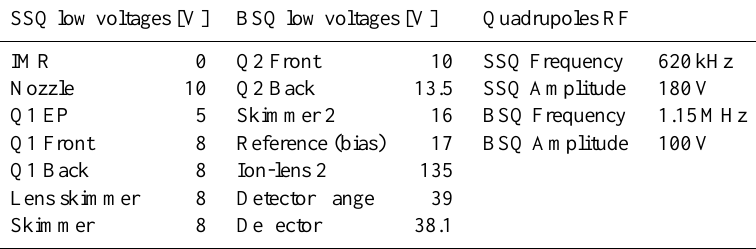
Table A2. Voltages and frequencies in the APi section.